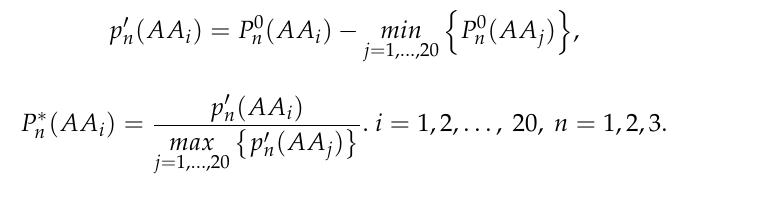
Table 1. The original numerical values for the properties of the 20 native amino